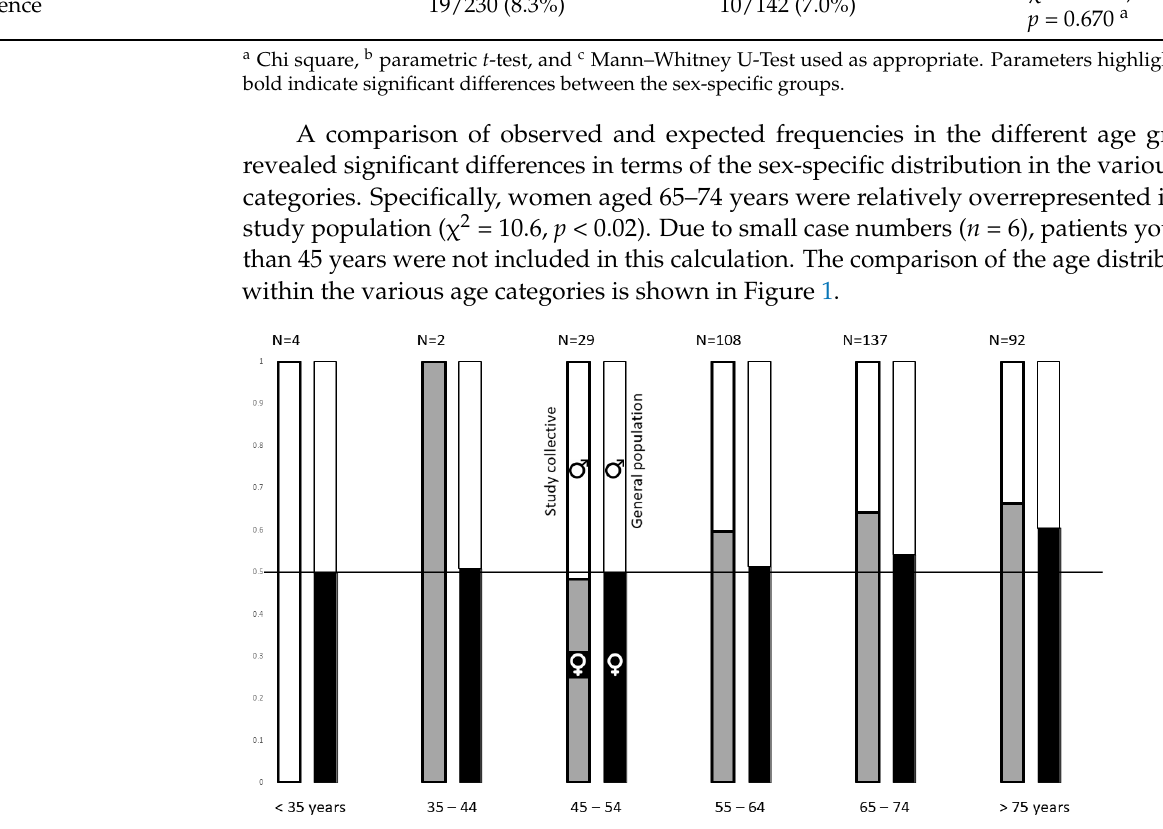
Figure 1. Grouped and stacked bar chart showing the relative sex distribution (y-axis) in different age groups (x-axis) in the study population (left column in each case) compared to the general population in the catchment area of the clinic according to public population data from 2019 (right column in each case) [25]. The left column in each case represents the relative distribution of women (grey, bottom) and men (white, top) among the study population in the indicated age group. The right column comparatively shows the relative frequency in the general population of women (black, bottom) and men (white, top). The horizontal line at height y = 0.5 indicates an equal sex distribution of 50% female. The absolute frequency of TGA patients in the corresponding age group is indicated above the study population bar ( n = ...). Caution is advised when reading the columns of the study population in the age group <35 years ( n = 4, exclusively men) and the group 35–44 years ( n = 2, exclusively women). Due to the small number of cases and exclusive inclusion of one group of sex, the column is only one colour in these